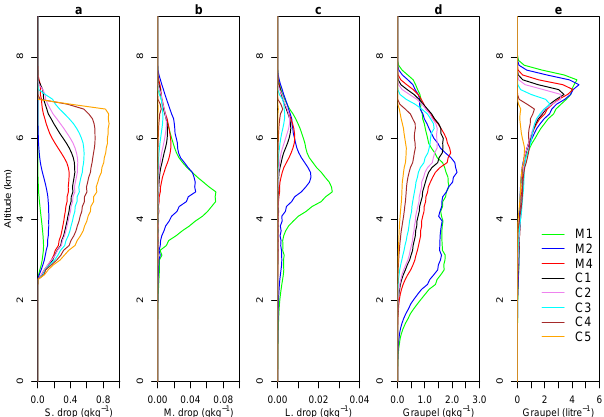
Fig. 6. Drop masses at the cloud centre for (a) small drops (diameter < 50µm), (b) medium-drops (50µm < diameter < 1000µm), and (c) large drops (diameter > 1000µm). Also shown are (d) mean graupel specific mass, and (e) graupel number concentration at 40min from MO-v2. See text for definitions. The mass and concentration of graupel are averaged over grid points where there is graupel.